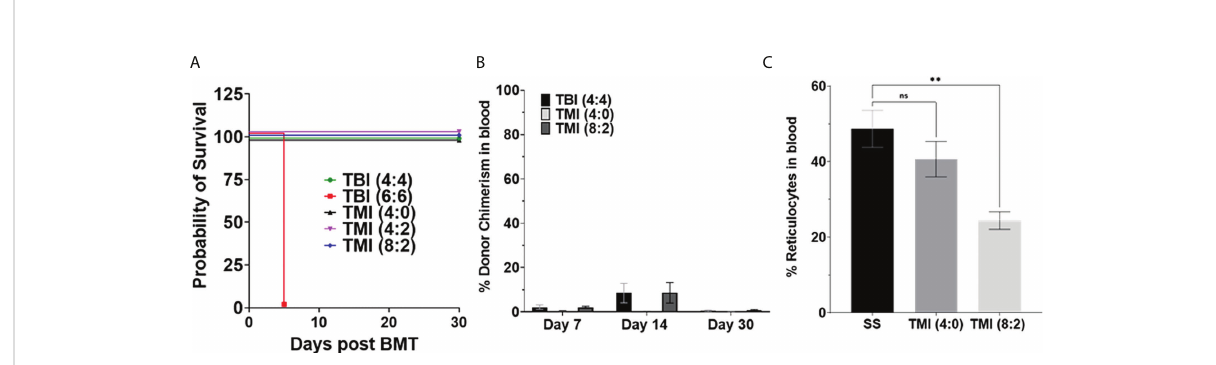
FIGURE 2 Sickle cell disease mice tolerated radiation dose and chimerism post-BMT. Berkeley SS mouse was treated with different dose of radiation and transplanted with 5 million donor AA bone marrow cells, and survival and chimerism were monitored over 30 days post-BMT. (A) Kaplan – Meier survival curve showing that TBI 6 Gy was lethal even after BMT, while TMI (8:2) was tolerated by SS mice ( n ≥ 3). (B) Donor chimerism was measured in blood at D7, D14, and D30+ post-BMT. The data are representative of one experiment ( n = 5) and was not repeated due to the limited availability of mice. (C) Peripheral blood reticulocytes were analyzed using BD Retic-Count by fl ow cytometry. The TMI (8:2) showed lower reticulocytes than TMI (4:0), perhaps due to initial donor chimerism seen at D14, suggesting that donor RBCs transplanted could temporarily rescue this phenotype. Signi fi cance was determined using two-tailed Student ’ s t -test and two-way ANOVA and was considered signi fi cant when p -value was <0.05. ns= non-signi fi cant, ** p <